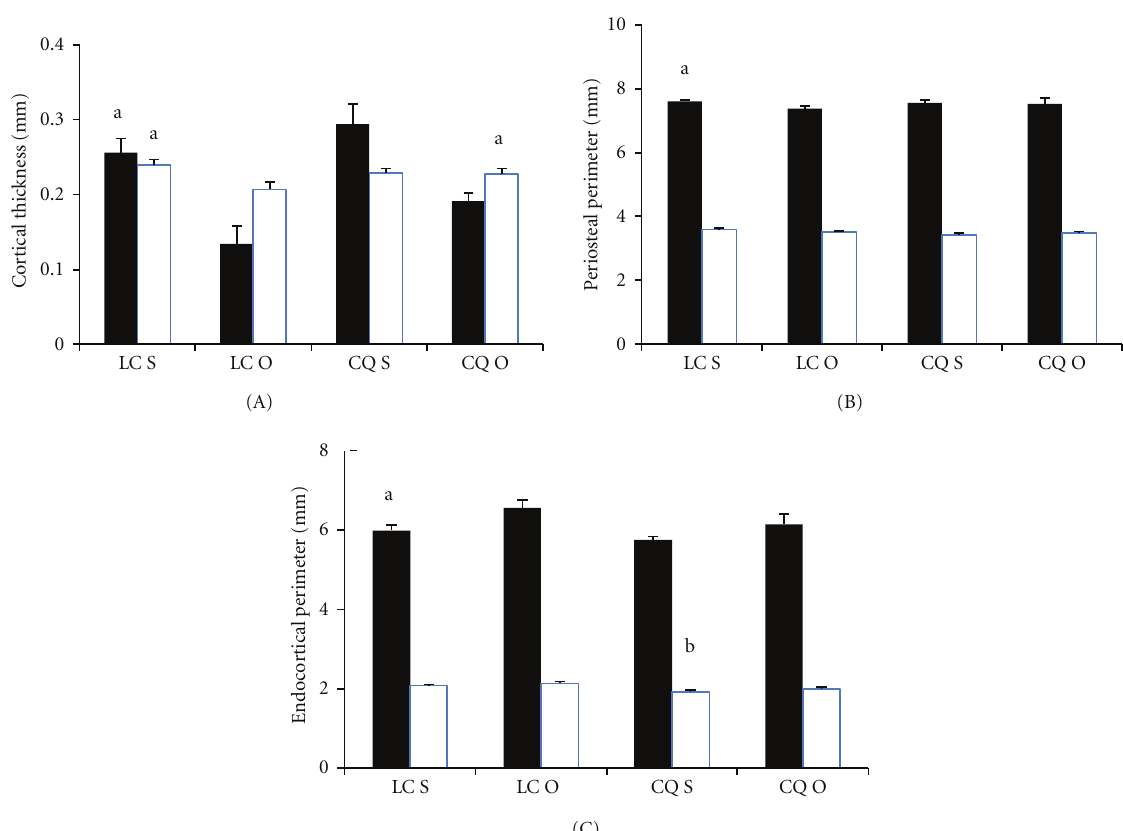
Figure 4: E ff ects of Cissus quadrangularis on the cortical bone thickness and perimeters of the proximal tibial metaphysis and tibia fibula junction of C57Bl/6 mice after ovariectomy using pQCT. Data are Mean ± SE. (A) Cortical thickness; (B) periosteal perimeter; (C) Endocortical perimeter. Black bars represent proximal tibial metaphysis; white bars represent tibia fibula junction. LC S:lab chow sham; LC O:lab chow ovariectomy; CQ S: Cissus quadrangularis sham; CQ O: Cissus quadrangularis ovariectomy. a P < 0 . 05 versus LC O; b P < 0 . 05 versus LC